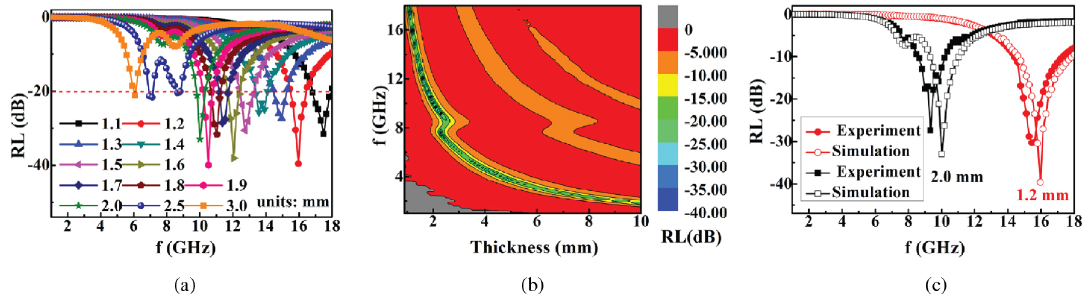
Figure 3. (a) Simulated RL coefficient curves of the paraffin-Cu nanocapsules composite as a function of frequency. (b) Two-dimensional representation of RL coefficient derived from the measured and of the paraffin-Cu nanocapsules composite. (c) RL coefficient curves of the composites with the different thickness as the function of frequency for simulation and